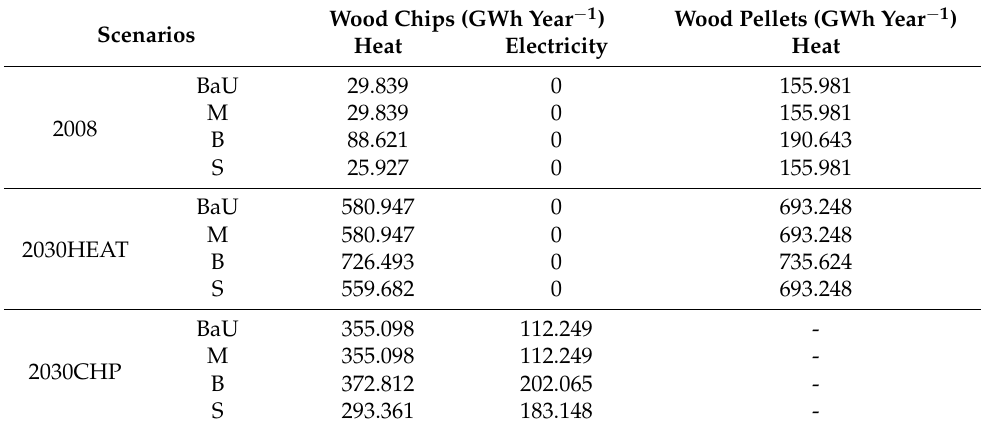
Table 5. Heat and electricity production for wood chip and wood pellet value chain scenarios.